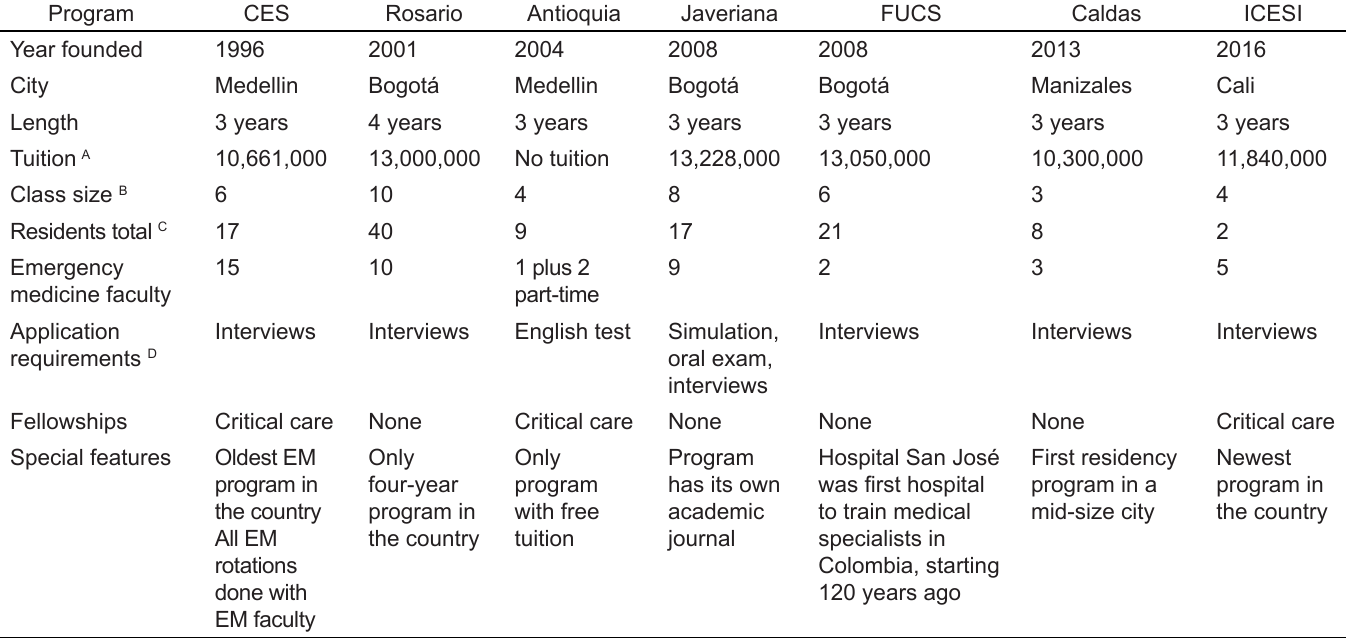
Table 1. General program characteristics of the seven emergency medicine residency programs in Colombia, which differ in tuition, length, number of faculty, number of residents and fellowships